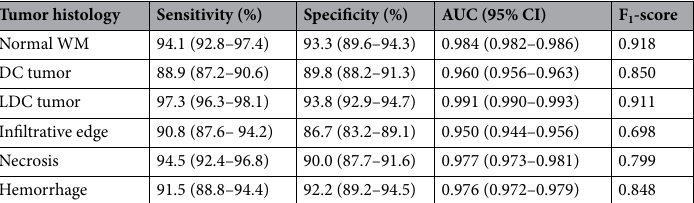
Tumor histology Sensitivity (%) Specificity (%) AUC (95% CI) F 1